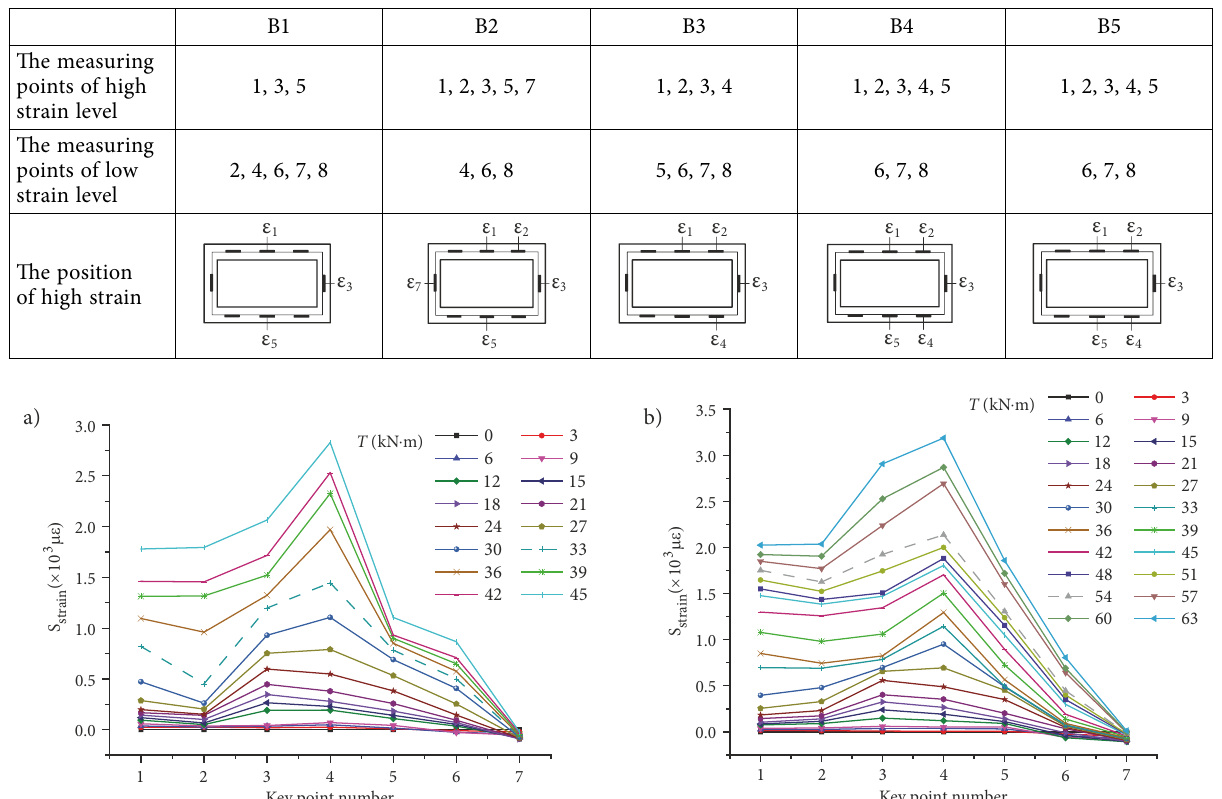
Table 2. Distribution of the strain level at measuring points of RC box-girders